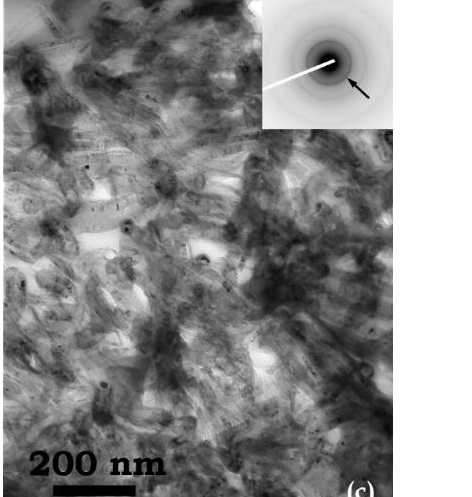
Figure 5. ( a ) TEM image of the PEF/0.25 GNPs/1 CNTs hybrid nanocomposite showing a large CNT aggregate, along with neighboring GNPs. In ( b , c ), the corresponding SAED ring patterns of CNT bundles are shown as insets, whereby the (0002) graphitic planes are denoted by arrows. In ( d ), the outer and inner diameters of individual CNTs are depicted by red and yellow lines, respectively.